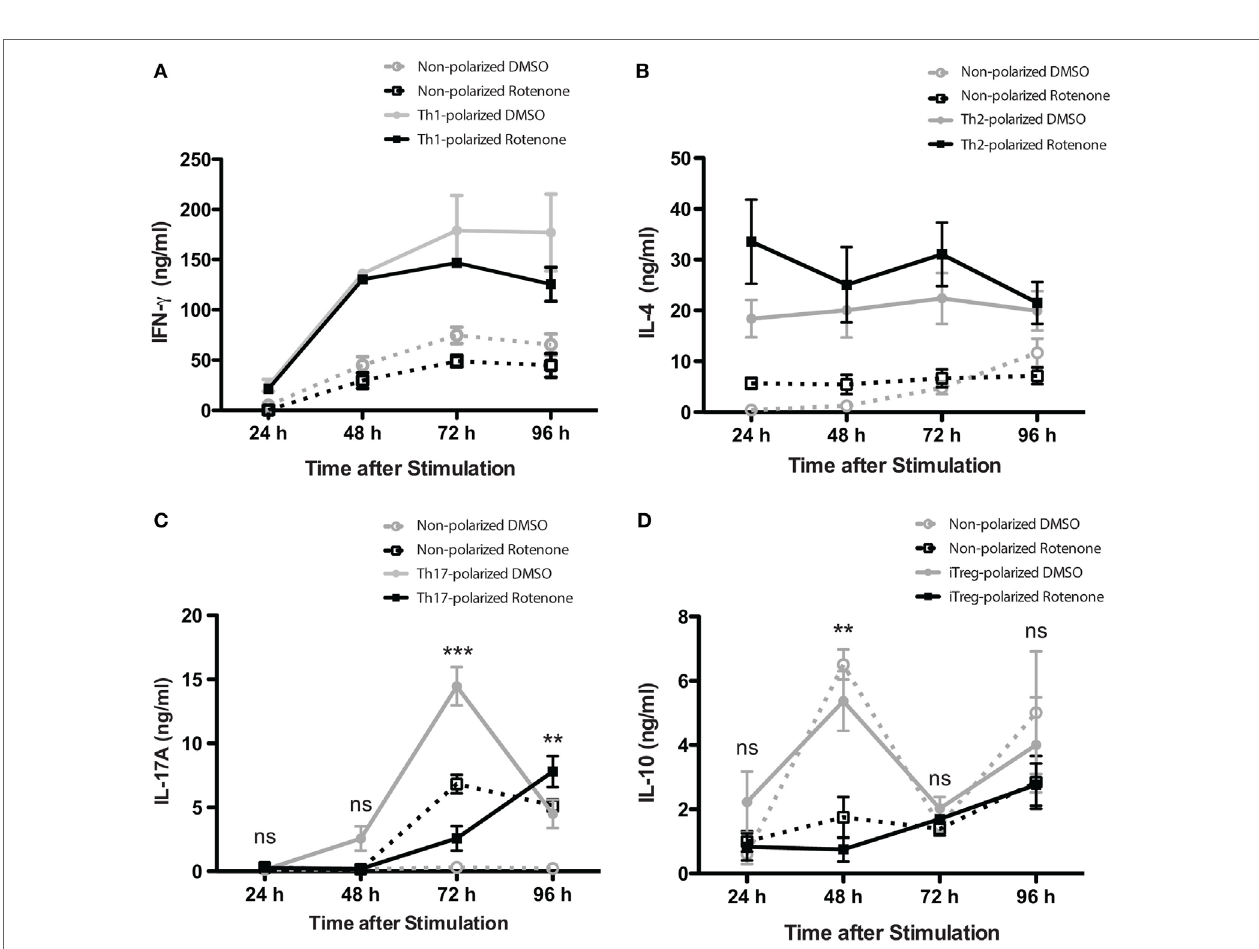
FigUre 1 | Rotenone treatment reduces T cell activation upon anti-CD3 ε plus anti-CD28 stimulation. Mouse splenic CD4 T cells were left untreated or treated with 20 µM rotenone for 2 h, then stimulated with plate-bound anti-CD3 ε plus anti-CD28 for 24 h. CD25 and Notch1 levels were measured as read-outs of T cell activation via flow cytometry. (a) Representative contour plot showing CD25-expressing cells left unstimulated or stimulated in the presence or absence of rotenone for 24 h. The (B) percent CD25-positive, and (c) median fluorescence intensity (MFI) of CD25, as well as the (D) percent Notch1-positive (e) MFI of Notch1 on CD4 T cells, cultured as described above. At the end of 24 h of stimulation, culture supernatants were collected, and standard enzyme-linked immunosorbent assay techniques were used to quantify secreted (F) IFN γ and (g) IL-2. Data represent the mean ± SEM of three independent experiments. * p < 0.05; ** p < 0.01; *** p < 0.001; calculated using an unpaired, two-tailed Student’s t